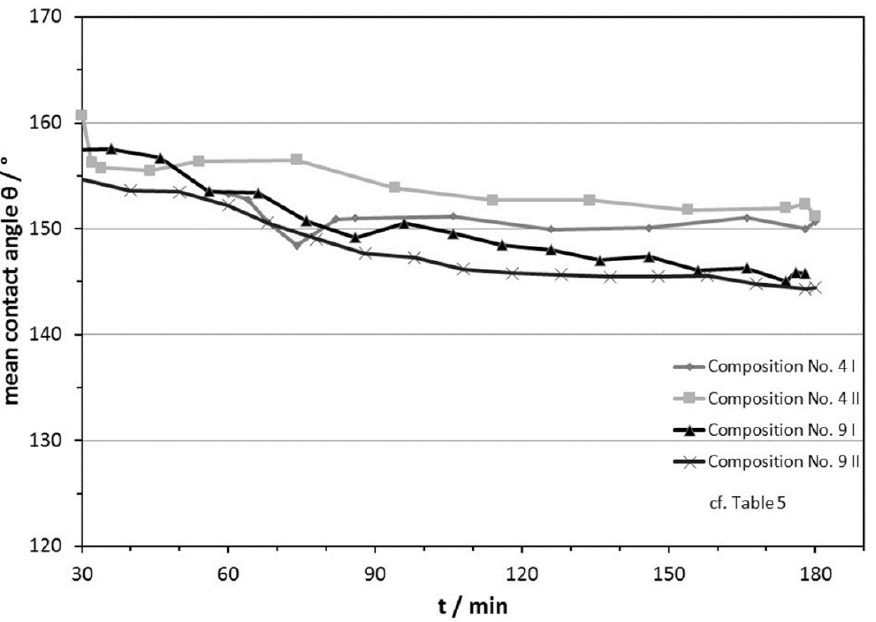
Figure 9. Measured time dependence of mean contact angles θ of AlSi7Mg droplets on MgAlON- containing substrates.